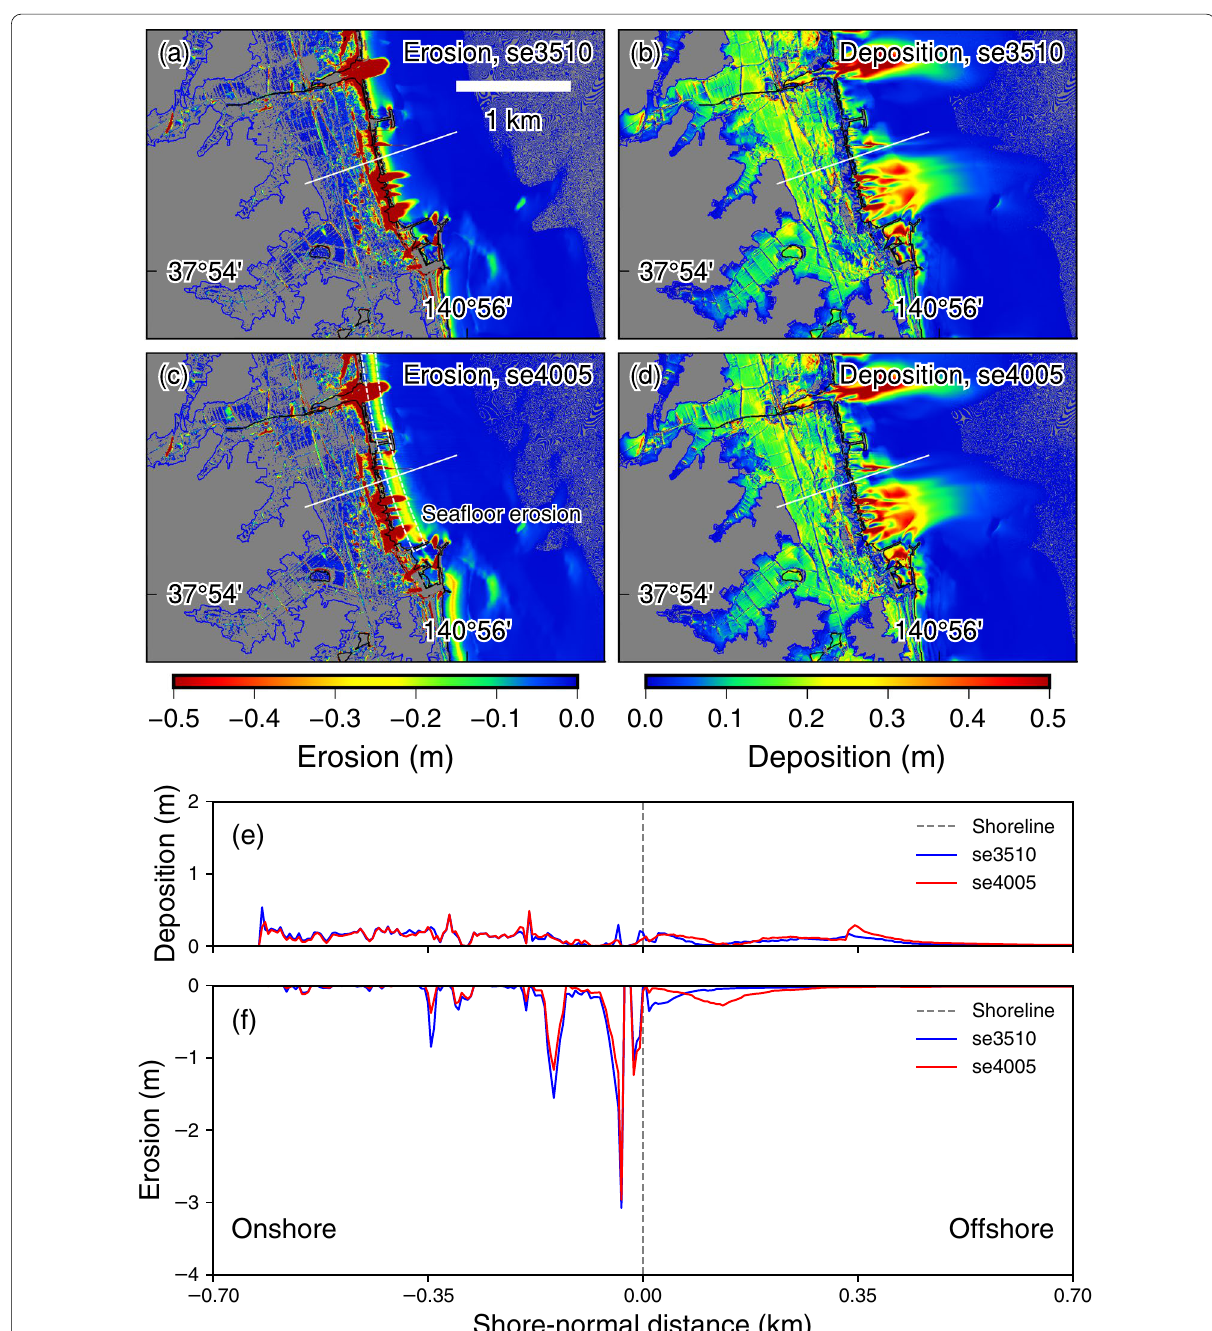
Fig. 9 Results of the sediment transport simulation using the source models, se3510 ( a and b ) and se4005 ( c and d ). Morphological changes (negative and positive values indicate erosion and deposition, respectively) around the Suijin-numa pond are displayed. Black lines represent post-tsunami 0 m contours for each scenario. ( e) Deposition trend of these scenarios along the transect are shown in ( a – d ) as a white line. ( f ) Erosion trends along the same transect as ( e